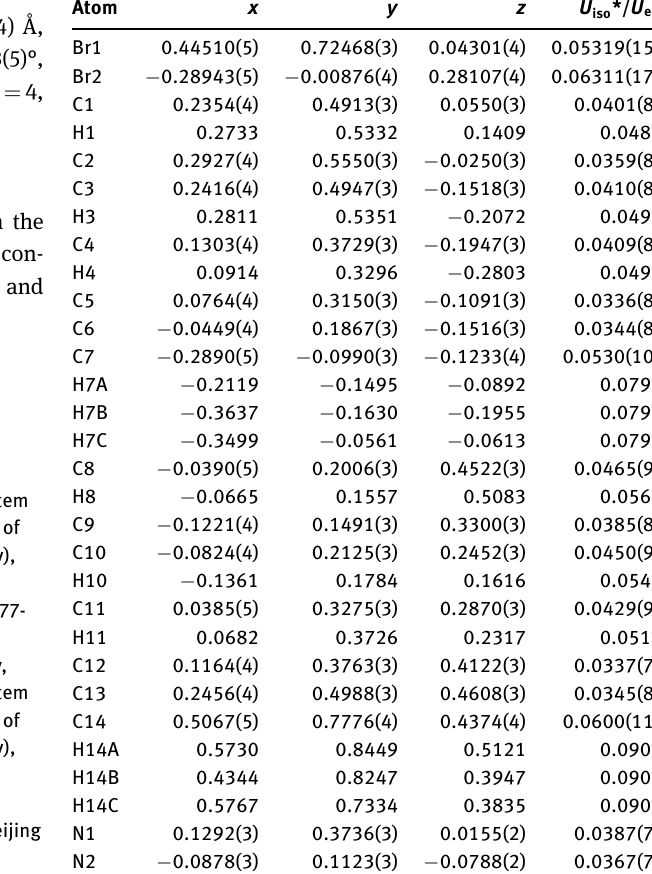
Table 2: Fractional atomic coordinates and isotropic or equivalent isotropic displacement parameters (Å 2